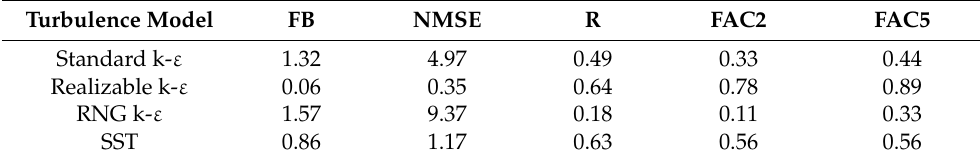
Table 2. Statistical evaluation of simulation results of different turbulence models. Turbulence